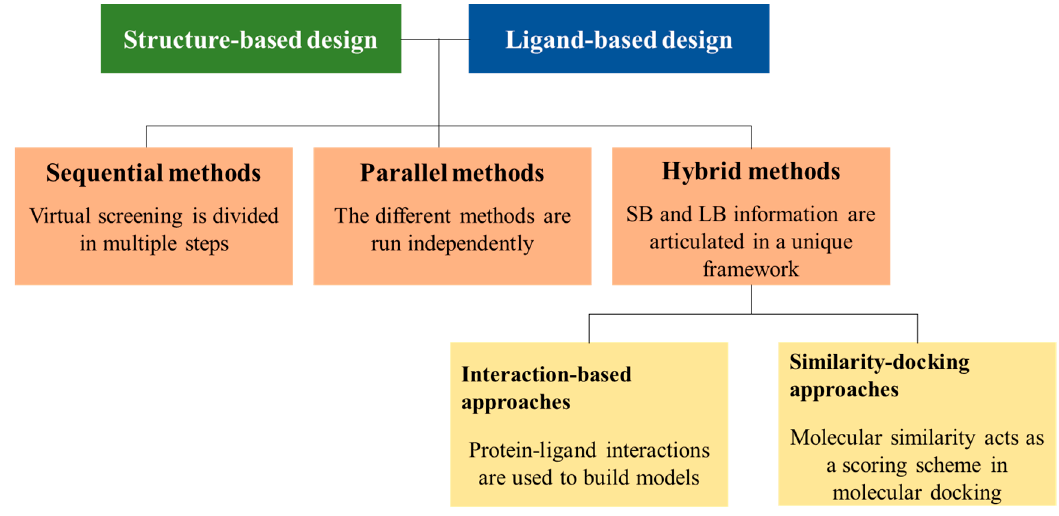
Figure 2. Schematic representation of the three main strategies adopted for combining LB and SB